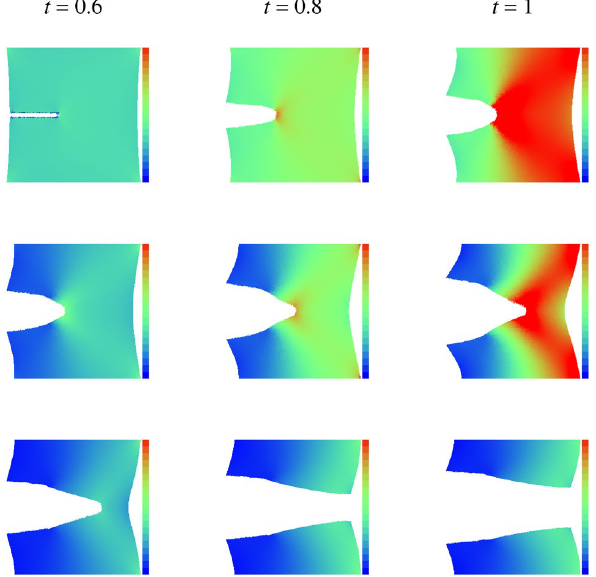
Fig. 18 Time evolution of the deformations of the system with η = 4 (upper), η = 5 (middle) and η = 6 (lower). Blue color indicates low values, red color high values of the squared amplitude of the ̂ e flowed strain | |